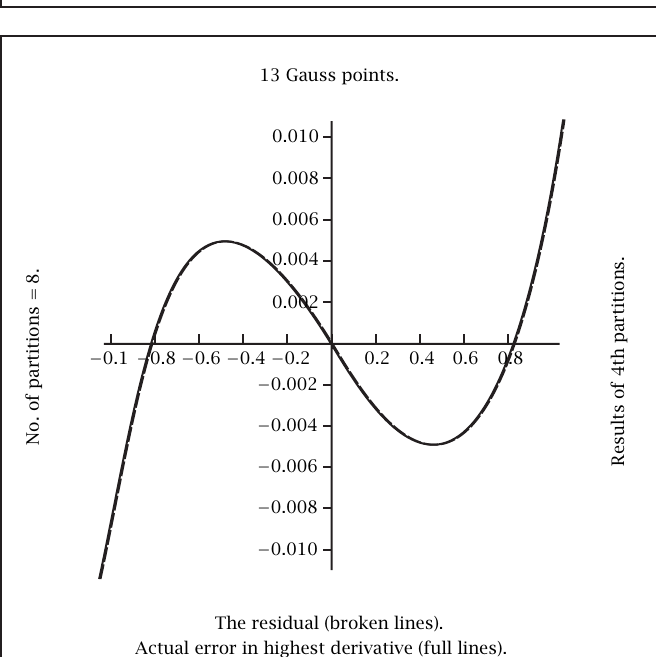
The residual (broken lines). Actual error in highest derivative (full lines).